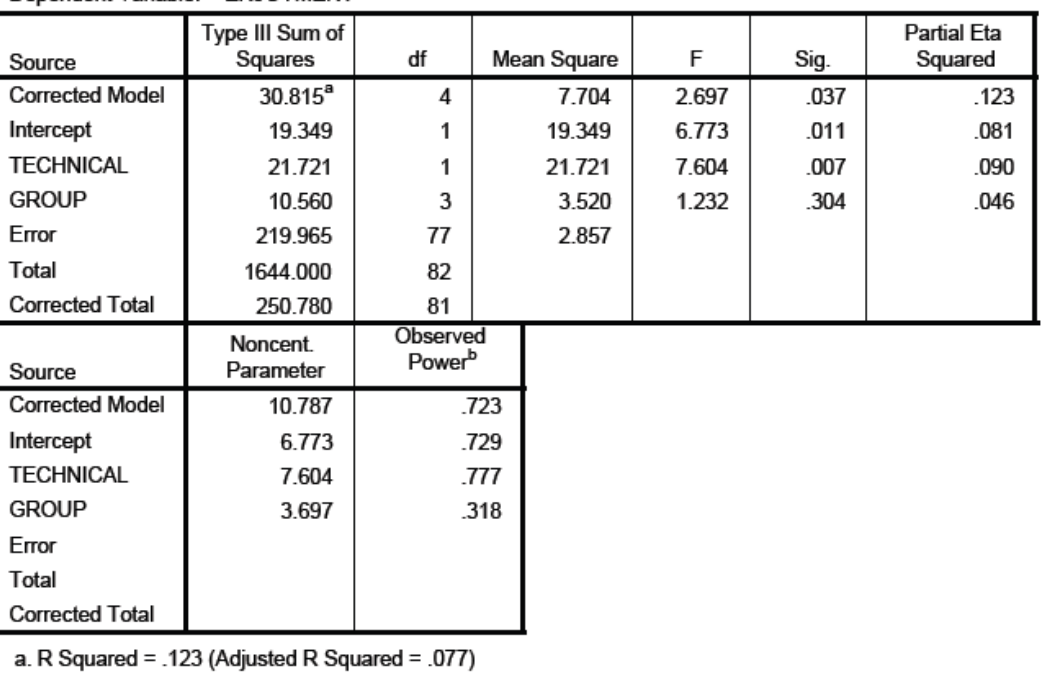
Figure B.14. ANCOVA analysing enjoyment levels between the four groups of participants using data adjusted for technical